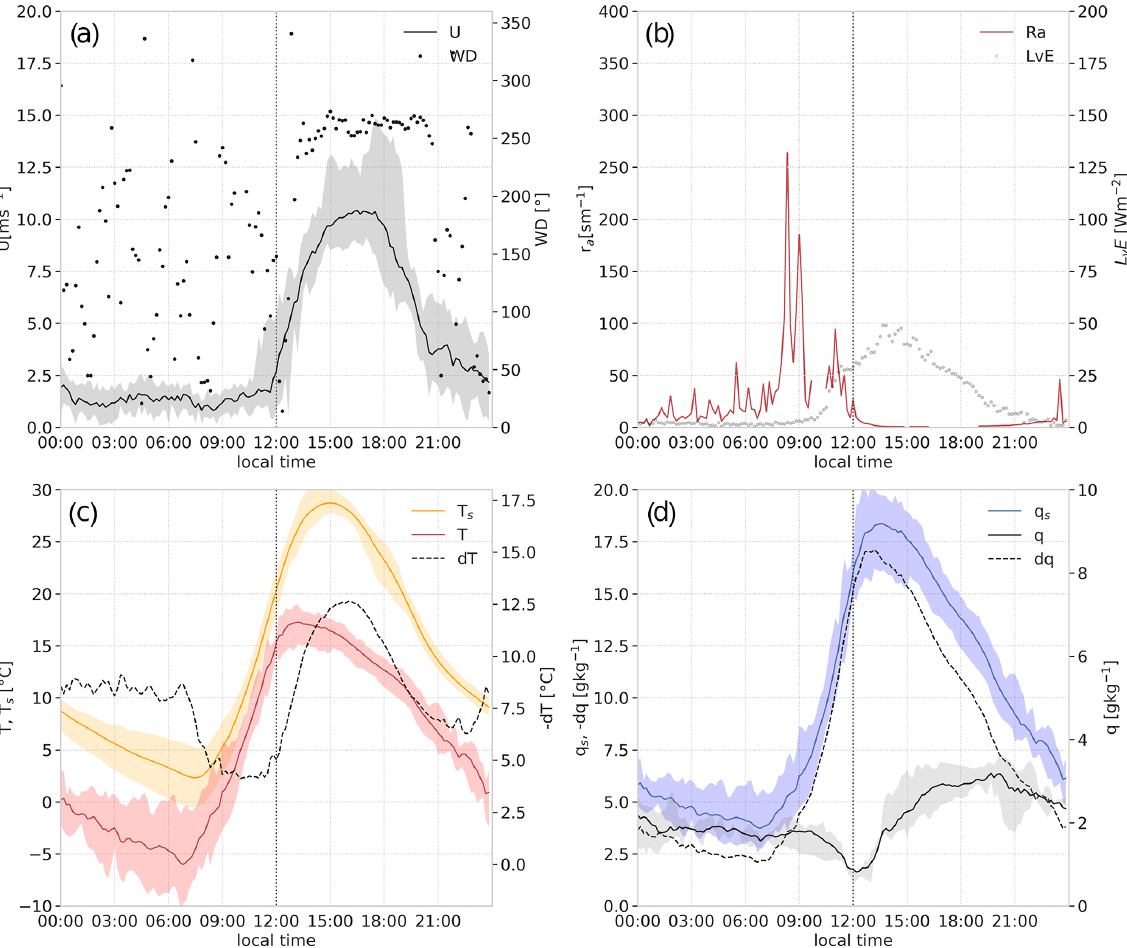
Figure B2. (a) Mean diurnal cycle of wind speed ( U ) and wind direction (WD) of a representative day (18 November); (b) mean diurnal cycle of aerodynamic resistance ( r a ); (c) air temperature ( T ), surface temperature ( T s ) and thermal gradient ( − d T ); and (d) air specific humidity ( q ), surface saturated specific humidity ( q s ) and moisture gradient ( − d q ) observed over the wet-salt surface. Vertical dotted lines indicate time of turbulent regime change, and shadings represent maximum and minimum observations. Observations from 15–24 November